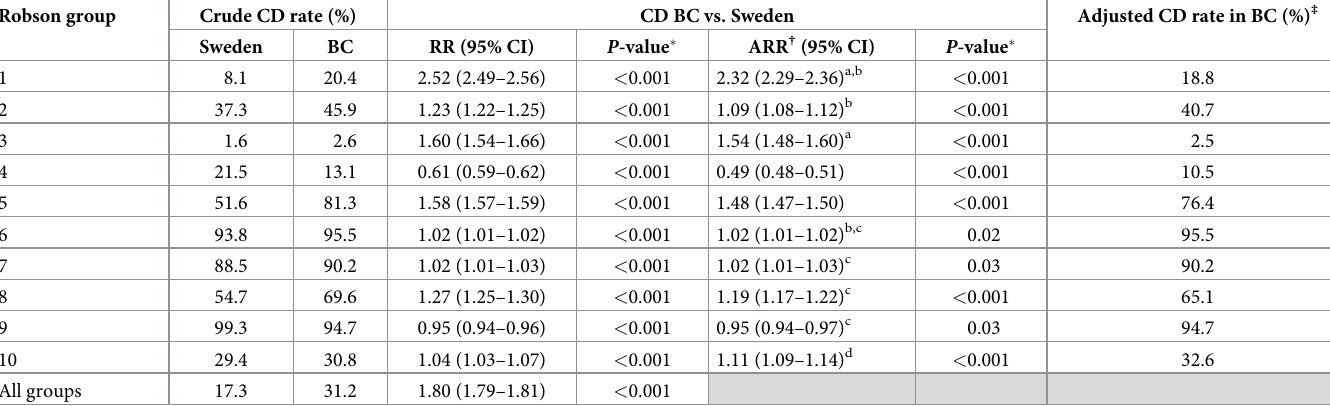
Table 3. Crude and adjusted rates and rate ratios for CD in BC vs. Sweden by Robson group,